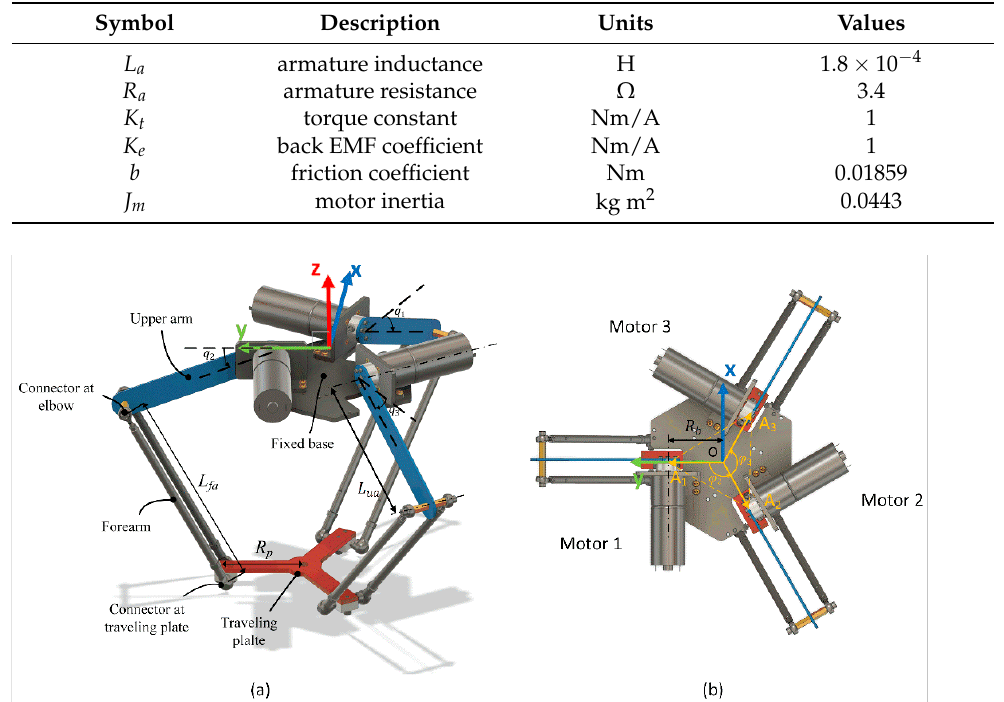
Table 1. Parameters of the DC motor.